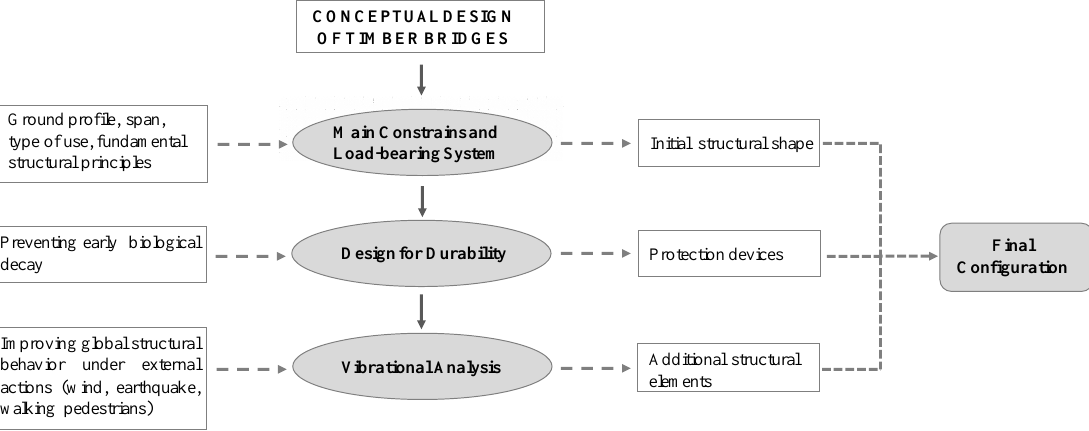
Figure 2. Flow-chart of the proposed methodology for the conceptual design of timber bridges.